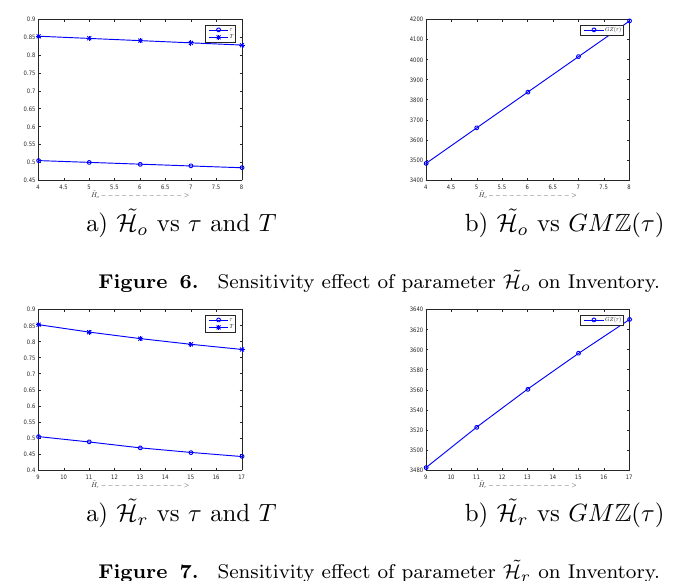
Figure 7. Sensitivity effect of parameter ˜ H r on Inventory.